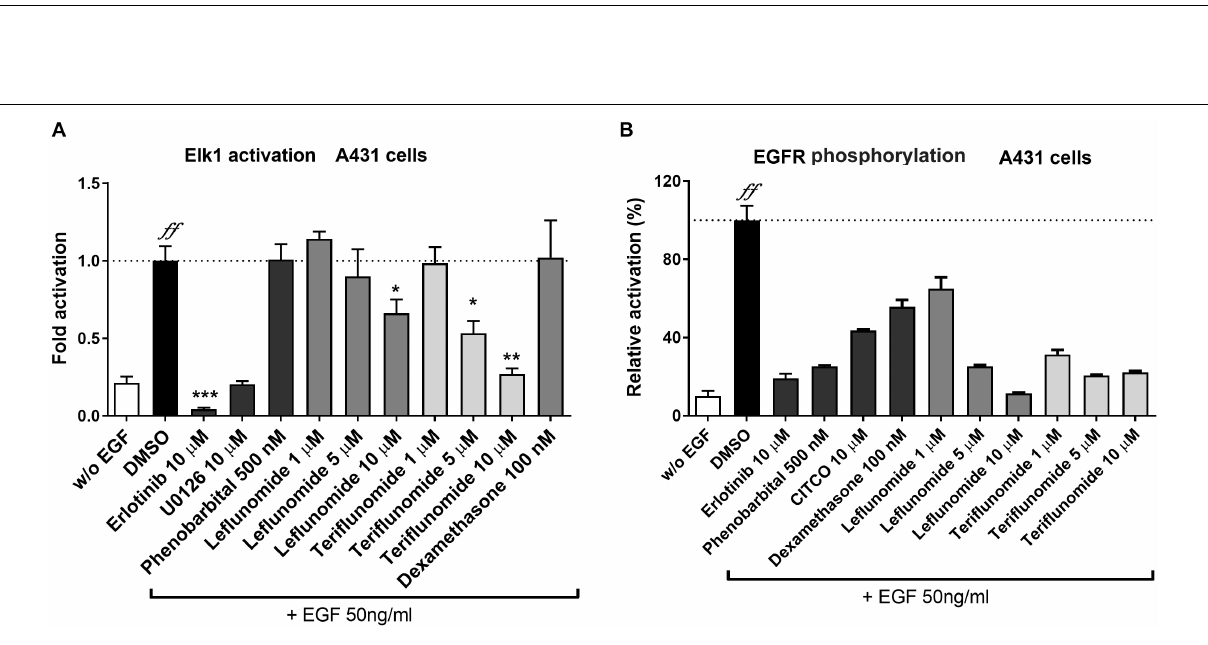
FIGURE 4 | Neither leflunomide nor teriflunomide dock to hCAR LBD. Molecular docking into the crystal structure of hCAR was performed using PDB structure 1XV9 chain B. (A) Structure of the docked binding pose of pregnane-3,20-dione (green). (B) Leflunomide (blue) and Z -enol form of terflunomide (magenta) do not form hydrogen bonding (H-BOND) with His203, which is important for the pose stabilization of pregnane-3,20-dione in hCAR cavity.